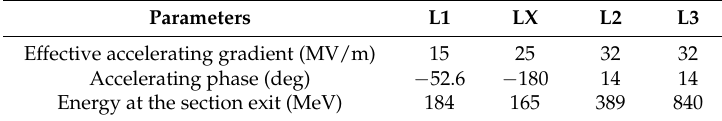
Table 3. Designed working parameters of the main linac. (Reprint from reference [26]).